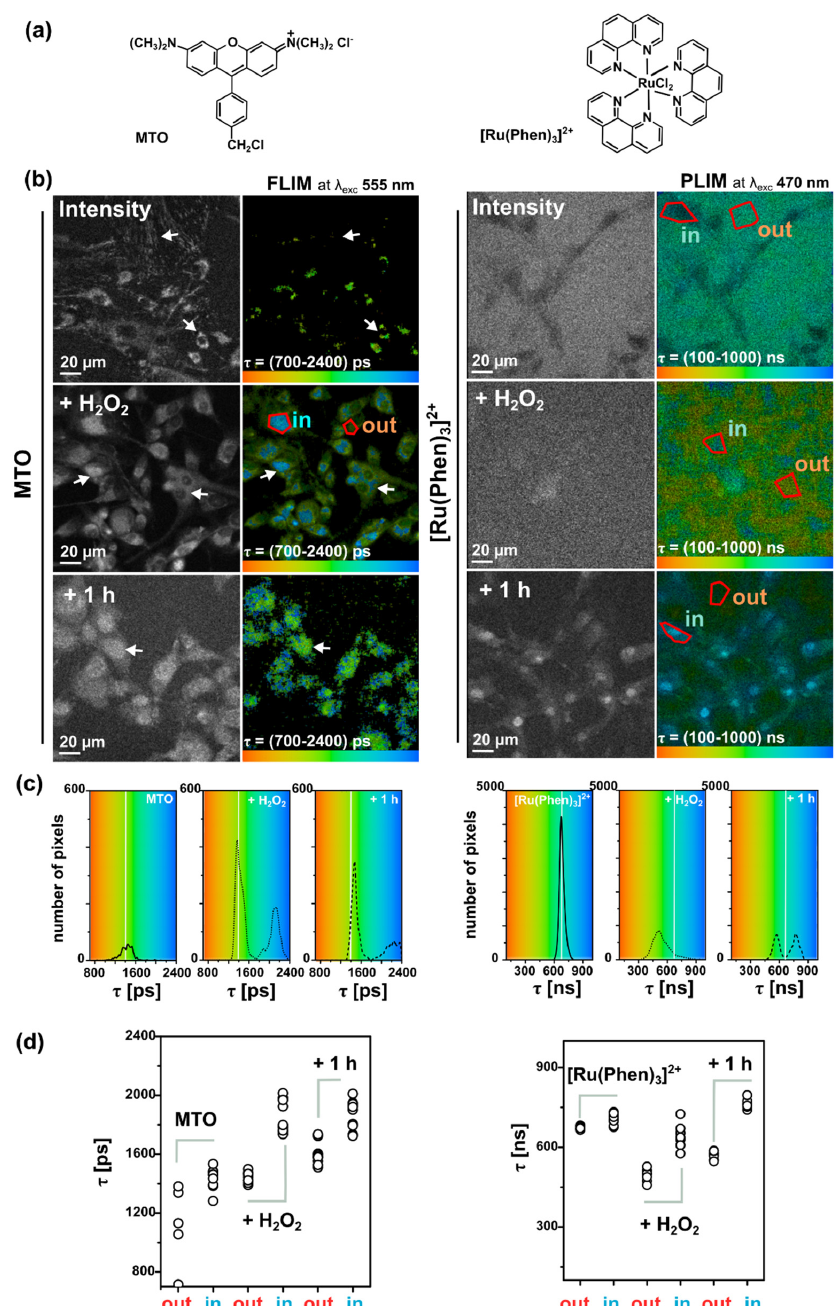
Figure 8. ( a ) Chemical structures of MTO (left) and [Ru(Phen) 3 ] 2+ (right). ( b ) Representative FLIM and PLIM images of MTO (left) and [Ru(Phen) 3 ] 2+ (right) individually applied in the medium of U87 MG cells for 30 min in the absence and presence of 200 µM H 2 O 2 (shortly and 1 h after H 2 O 2 administration). White arrows point to MTO mitochondrial and nuclear localization. The MTO fluorescence lifetimes ROI was selected in the perinuclear/nuclear area (in) and far from this area (out). The [Ru(Phen) 3 ] 2+ luminescence lifetimes ROI were selected in the intracellular (in) and extracellular area (out). ( c ) MTO and [Ru(Phen) 3 ] 2+ luminescence lifetime distribution histograms. The luminescence lifetimes are color-coded (minima—red, maxima—blue). Gray-scaled images represent the luminescence intensity of MTO and [Ru(Phen) 3 ] 2+ . The samples were excited with laser light at 555 nm (MTO) and 470 nm ([Ru(Phen) 3 ] 2+ ). ( d ) MTO and [Ru(Phen) 3 ] 2+ luminescence lifetime values detected at the conditions mentioned in ( b ). At least ten representative ROI was